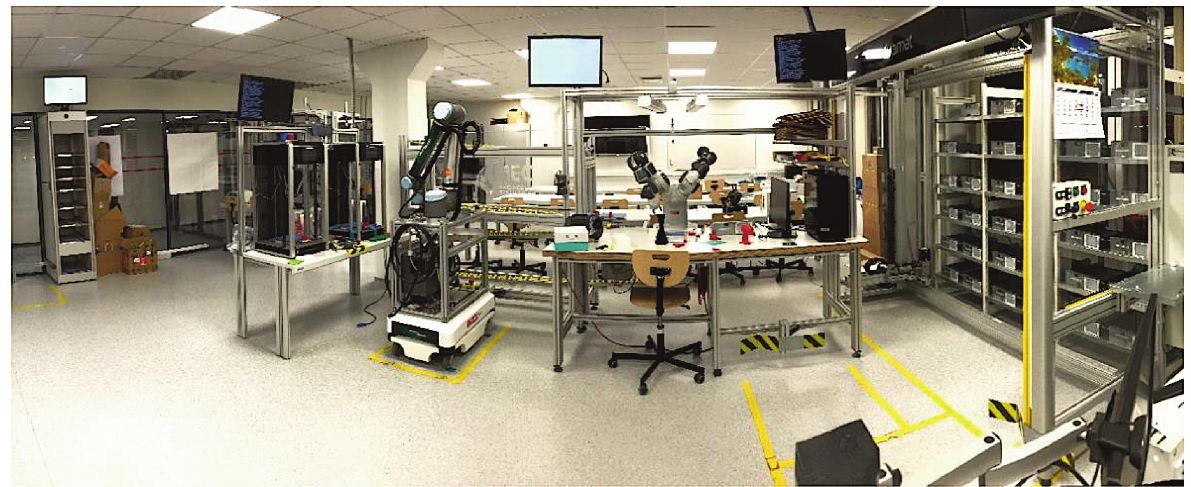
Fig. 4. TTK Industry 4.0 CPS.